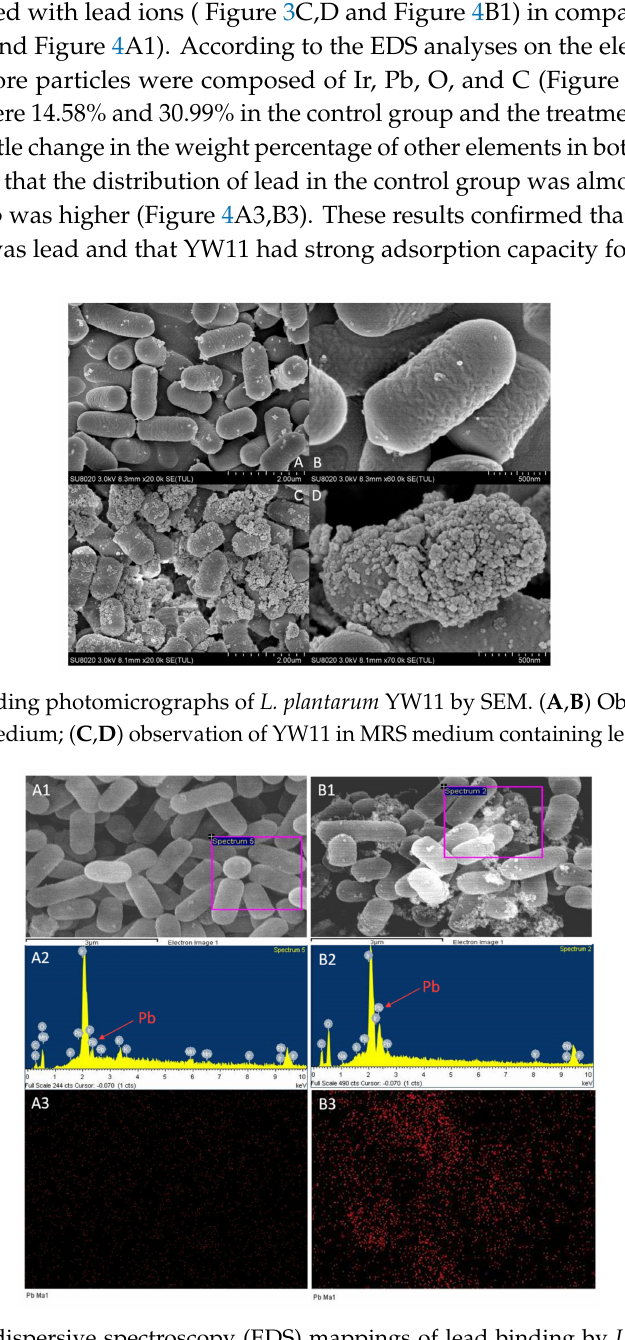
Figure 4. Energy dispersive spectroscopy (EDS) mappings of lead binding by L. plantarum YW11. ( A1–3 ) Observation of YW11 in lead-free MRS medium; ( B1–3 ) observation of YW11 in MRS medium containing lead ions (100 mg / L). ( 1 ) Photomicrographs of L. plantarum YW11 by SEM; ( 2 ) EDS spectrum of YW11; and ( 3 ) EDS mapping of lead corresponding to ( 1